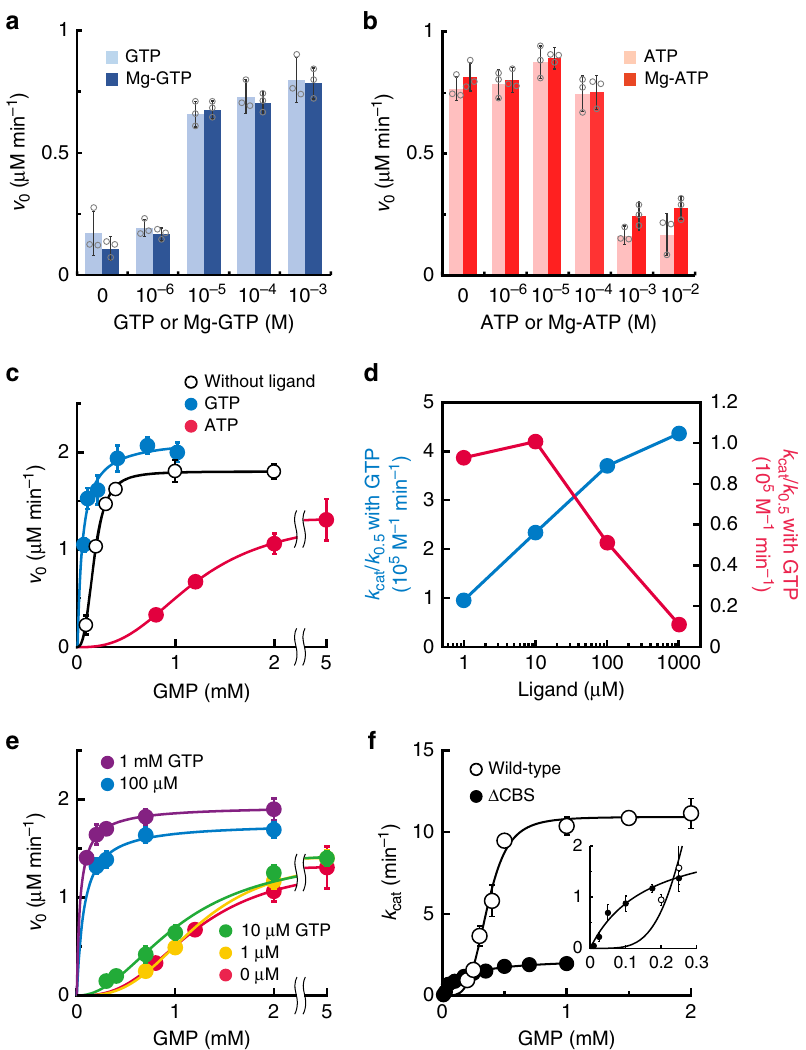
Fig. 1 Kinetic analysis of TbGMPR in the presence of purine nucleotides. a , b The initial velocities of TbGMPR in the presence of GTP ( a ) or ATP ( b ) at a fi xed concentration of GMP and NADPH. Each trinucleotide was used as a premix with ( solid bars ) or without ( shaded bars ) equivalent amount of magnesium ions. c The initial velocities of TbGMPR were plotted against the concentrations of GMP in the absence (open circles) or presence of 1 mM GTP (blue) or ATP (red) at a fi xed concentration of NADPH. Data were fi tted to the Hill equation, as described in the “ Methods ” . d The catalytic ef fi ciency ( k cat / K 0.5 ) of TbGMPR in the presence of various concentrations of GTP (blue) or ATP (red) ligand alone. e The initial velocities of TbGMPR in the absence (red) or presence of 1 (orange), 10 (green), 100 µ M (blue), or 1 mM GTP (magenta) under fi xed concentration of ATP at 1 mM. Note that the kinetics with GTP at 100 µ M and 1 mM showed a Michaelis – Menten-like pro fi le. f The k cat values of TbGMPR ( open circles ) and TbGMPR Δ CBS ( closed circles ) were plotted against the concentrations of GMP. The inset shows the data at low concentrations of GMP. Data were obtained from three independent experiments ( n = 3). Each data point represents a mean ± s.d. in error bars. Source data are provided as a Source Data fi le.